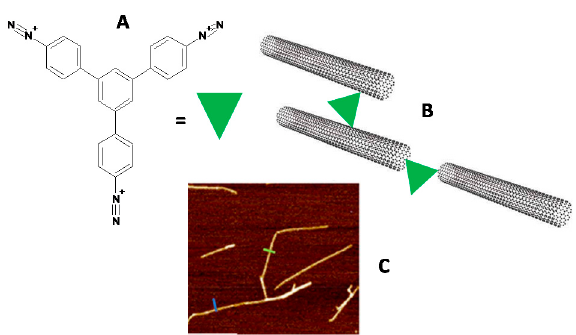
Figure 4. Array s of SWCNTs bonded by reaction of diazonium salts. Figure 4. Arrays of SWCNTs bonded by reaction of diazonium